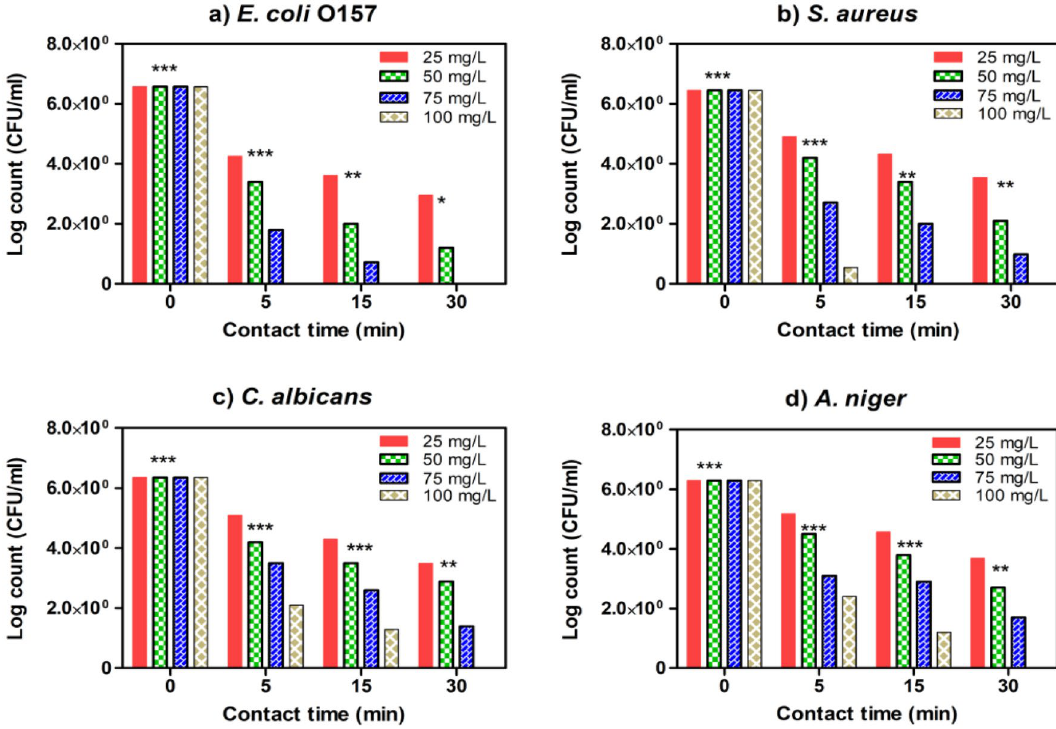
Figure 10. Estimated MIC values of SMZC-0.5Ni towards four tested microbial species, including ( a ) E. coli , ( b ) S. aureus , ( c ) C. albicans , and ( d ) A. niger . The remaining viable cell populations at various time intervals of 5, 15, and 30 min are displayed.